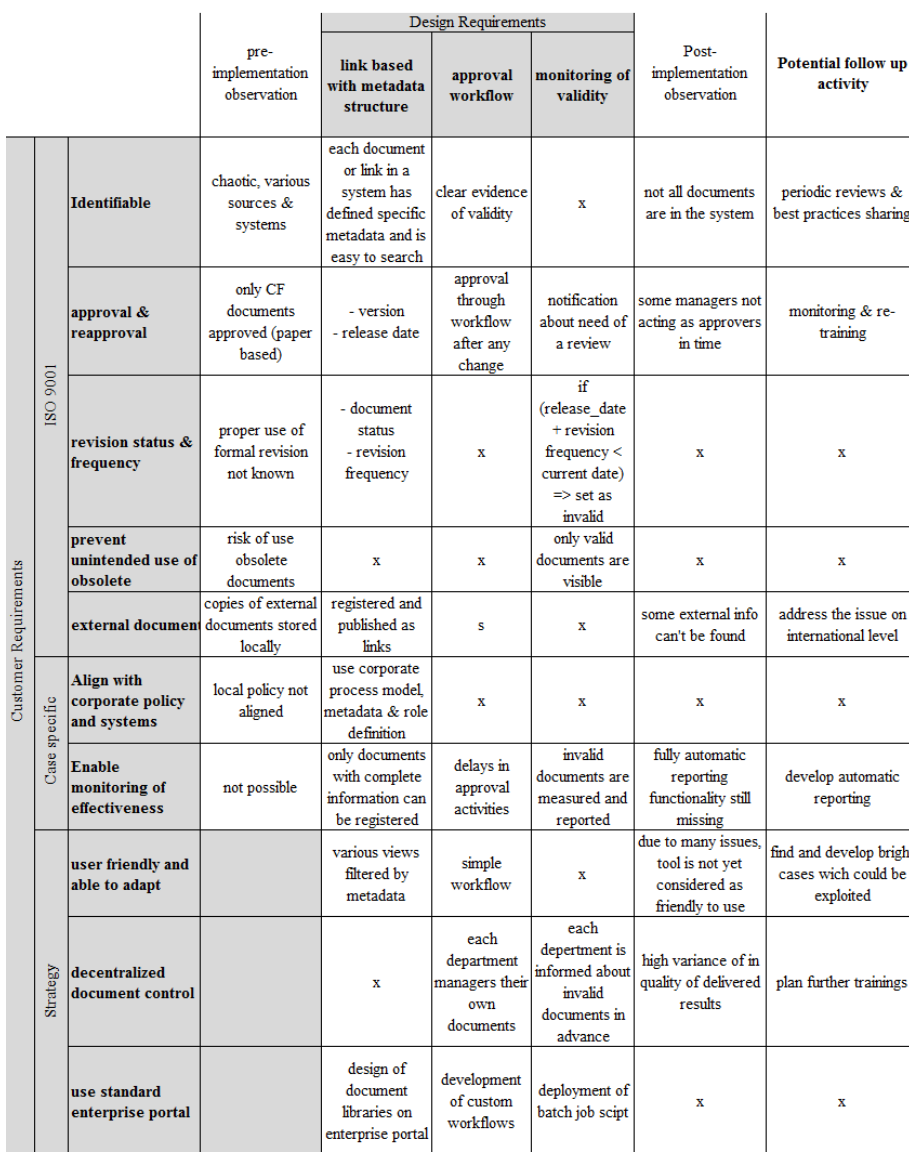
Figure 3 – Qualitative correlation & evaluation